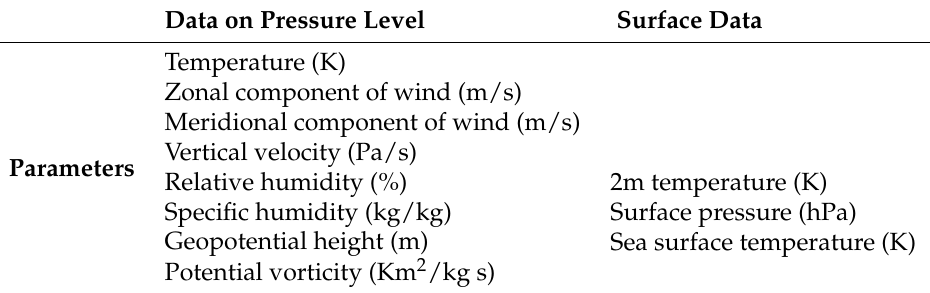
Table 1. ERA5 parameters for HYSPLIT input